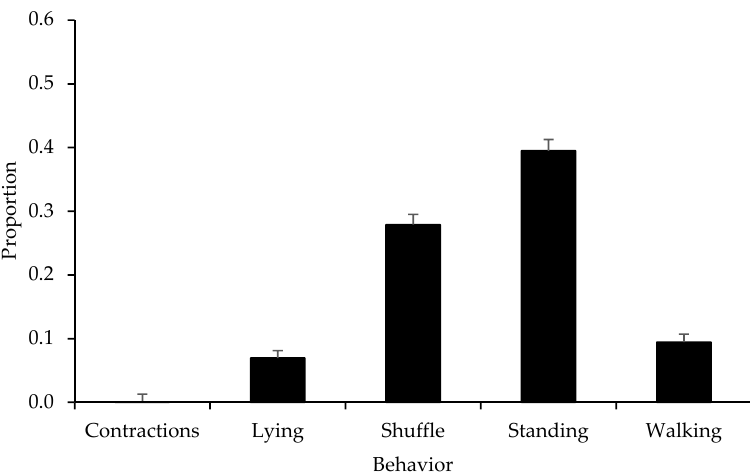
Figure 3. Predicted mean ( ± SEM) proportion of observations for different behaviors. Table 2. Effects of parity, time period, and lambing assistance on the frequency of behaviors as a proportion of observations. In the time period before lambing, the frequency of lying and contraction bouts in- creased and the standing and walking bouts decreased ( p < 0.001; Table 2), with a higher frequency of walking bouts in sheep that had an assisted lambing ( p < 0.01; Figure 4). There was no effect of parity on frequency of behaviors.